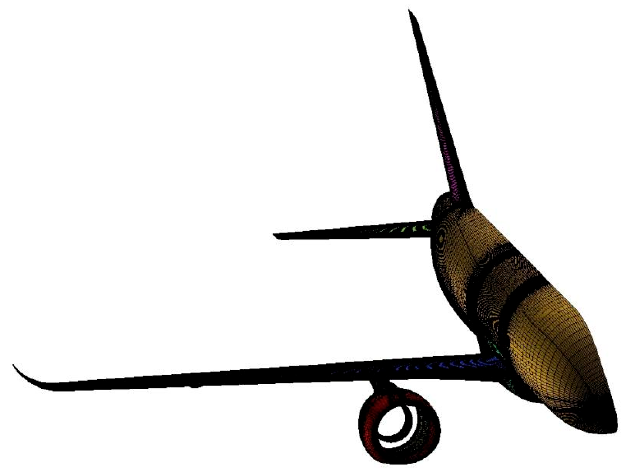
Figure 2. The wing–body interference DLM model.